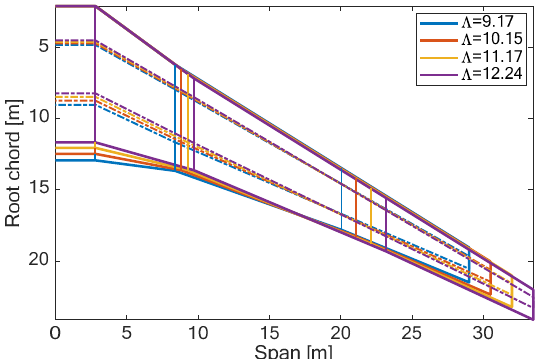
Figure 10. Planar view of the aspect ratio variation and spars positions (dashed lines). The aspect ratio is modi fi ed as in Table 7 and the result is represented in Table 10 . For each wing, the wingbox nondimensional position is maintained, i.e., the front spar posi- tion at the root is at 25.5% of the root chord and 25% of the tip chord, while the rear spar